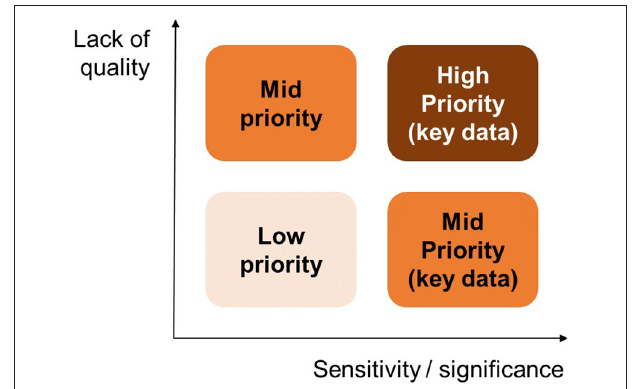
FIGURE 8 | Priority setting for improving data for inventory, adapted from EC-JRC